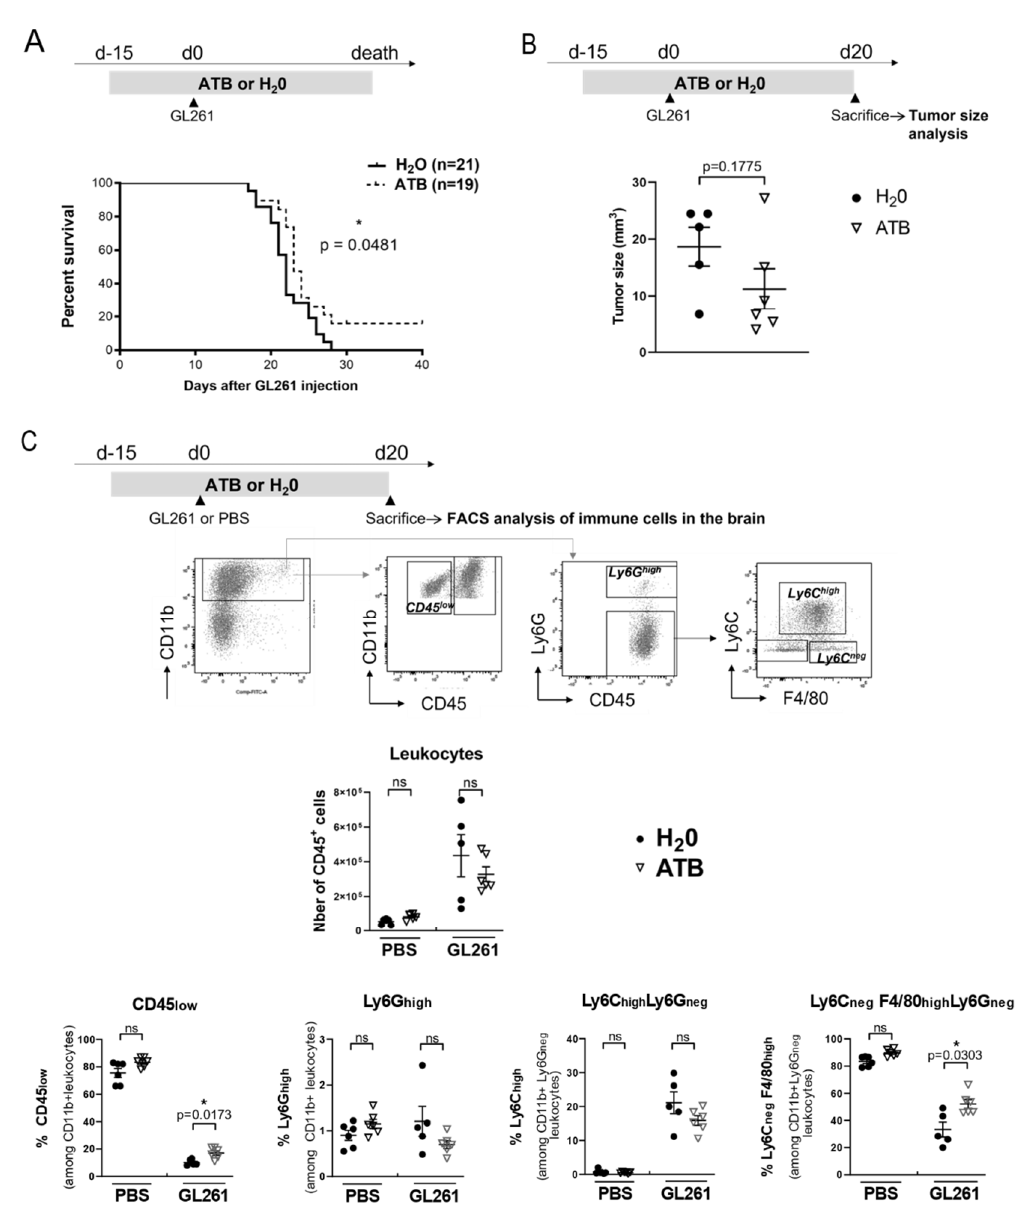
Figure 3. Antibiotic treatment delays mice death and changes the proportion of different myeloid cells in the brain ( A ) Survival curves of mice injected with GL261 and treated daily with antibiotics (ATB) ( n = 19) or H 2 O ( n = 21) by oral gavage 15 days before the surgery and until sacrifice. Log-rank test compared with control: see the indicated p -value ( B ) Tumor size of mice injected with GL261 ( n = 6) or PBS ( n = 5), 20 days after the surgery. ( C ) Absolute number and proportion of different immune cells (CD45 + ) in the brain of tumor-bearing (GL261; H 2 O n = 5; ATB n = 6) and healthy mice (PBS; H 2 O n = 6; ATB n = 6), by flow cytometry (FACS). A representative gating strategy is depicted. Mann–Whitney test compared ATB and H 2 O treated mice, * p < 0.05.